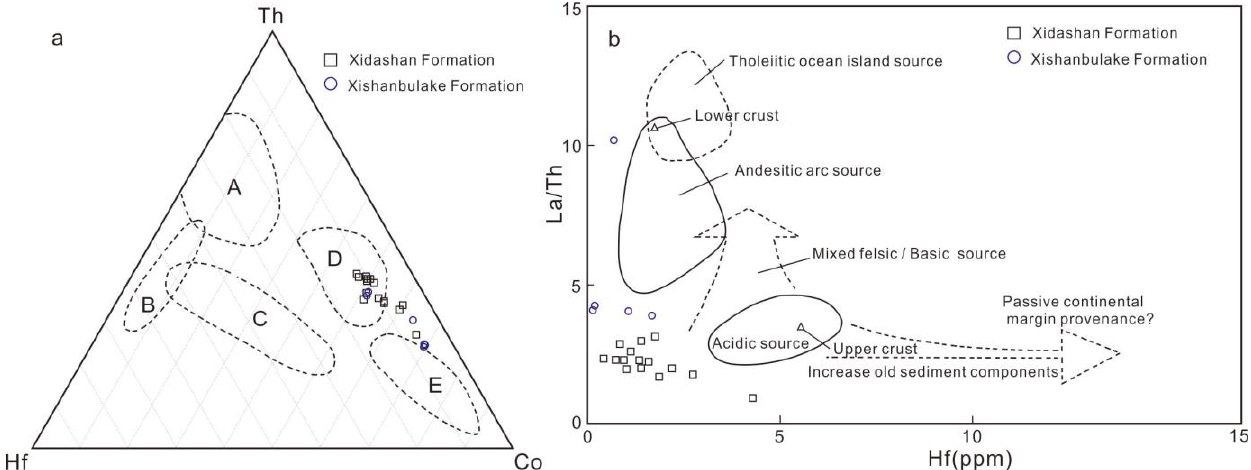
Figure 5. Discrimination diagram of the provenance properties of the Lower Cambrian mudstone in the Kongquehe area. ( a ) Th–Hf–Co discrimination (after Taylor and McLenna, 1985) and ( b ) Hf–La/Th diagram (after Floyd and Leveridge, 1987). A—felsic volcanic rocks; B—quartzite from cratonic basin; C—feldspar sandstones; D—shale (average upper continental crust); E—graywackes (arcs).